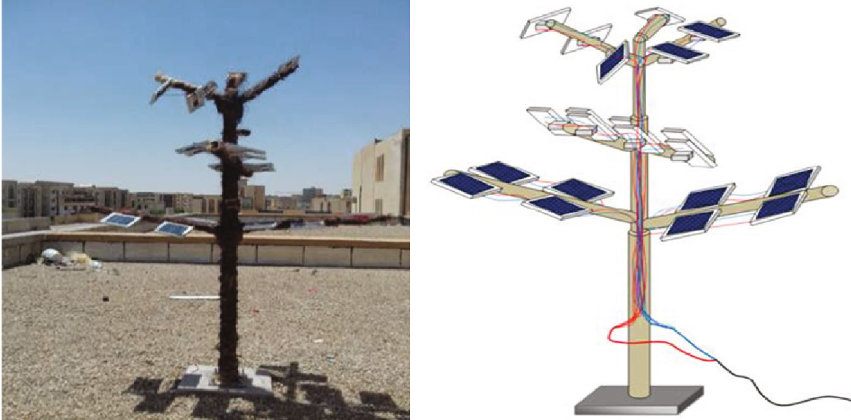
Figure 6: Solar tree.